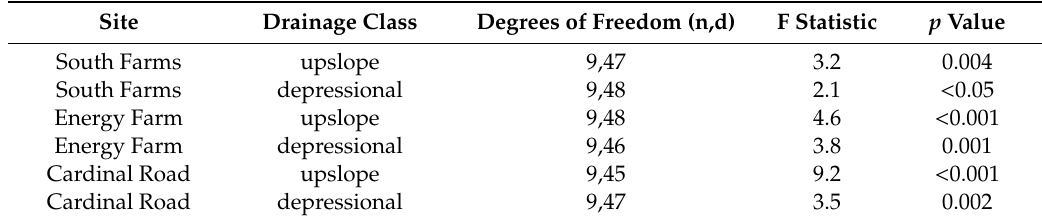
Table 1. Results from ANOVAs run on mixed e ff ects models examining the interaction e ff ect between treatment and date on soil CO 2 emissions during the late season lab